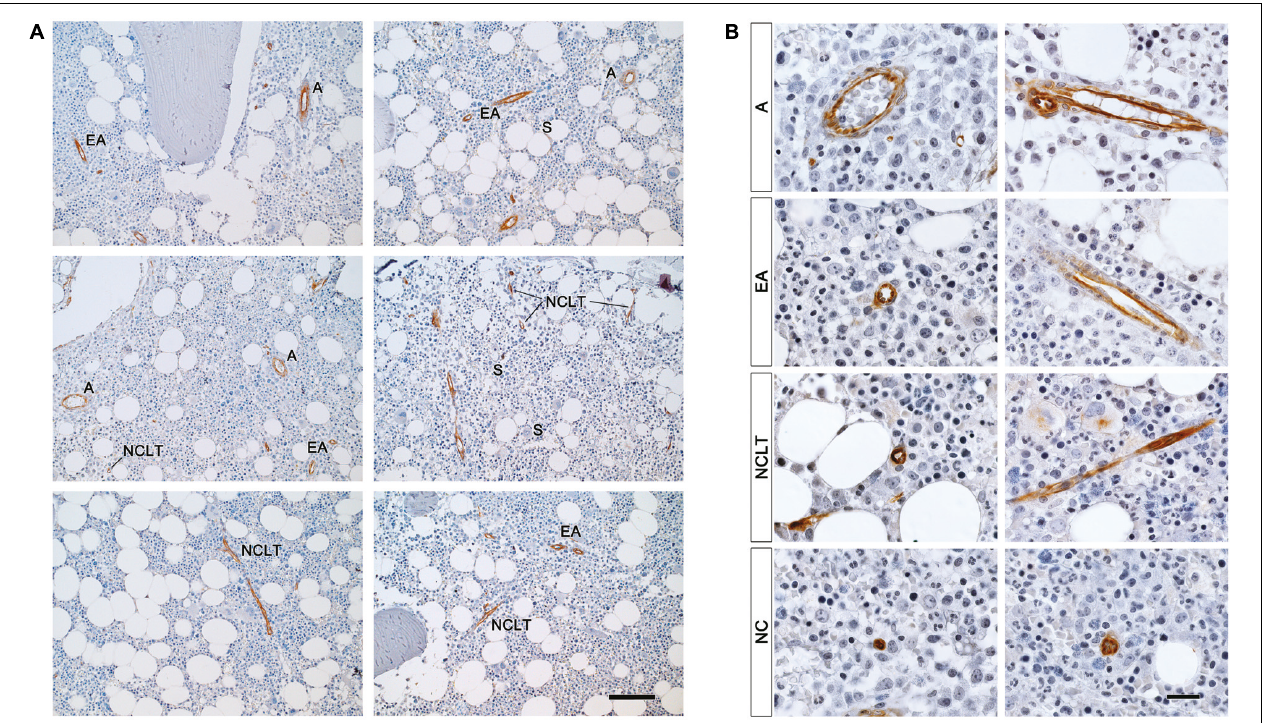
FIGURE 1 | NESTIN + vascular structures in human benign bone marrow. (A) Immunoperoxidase reaction revealed NESTIN expression in BMECs of arteries ( A ) and endosteal arterioles ( EA ) while sinusoids ( S ) showed negative. Positive NESTIN stain also revealed tubular vessels characterized by very small inner caliber and absence of NESTIN-positive perivascular cells we referred to as NESTIN + capillary-like tubes (NCLT). Scale bar = 200 µ m. (B) Under high power magnification, the intense NESTIN stain was confirmed in BMECs of arteries ( A ) and endosteal arterioles ( EA ). Some perivascular cells, showing elongated nuclei, in the perivascular region of A and EA showed weak NESTIN expression. Intense positivity was also detected in endothelial cells of capillary-like tubes ( NCLT ). NCLT capillary-like nature was confirmed by very high magnification power (1,000 × ) that showed lack of perivascular NESTIN-positive cells and presence of many